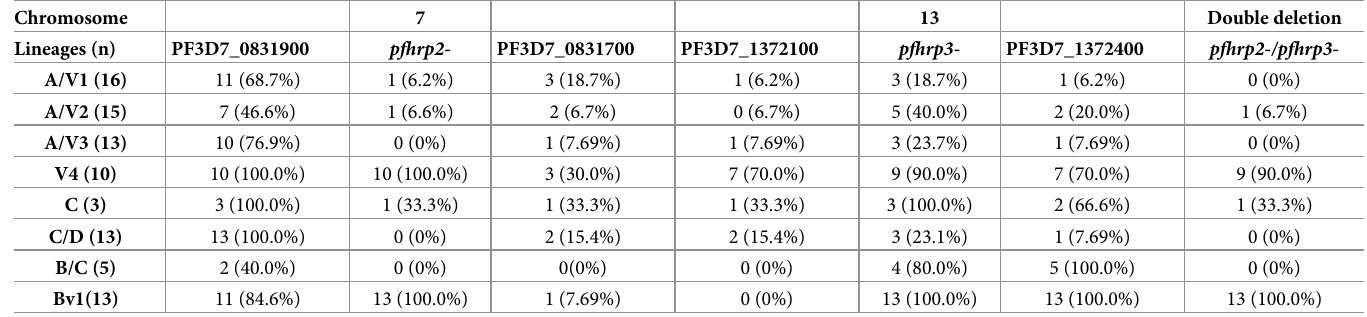
Table 5. Proportion of pfhrp2 , pfhrp3 and flanking gene deletions in Peruvian samples from different lineage identified. Data shows the number (and percentage) of parasites with gene deletions out of total samples tested. Chromosome 7 Double